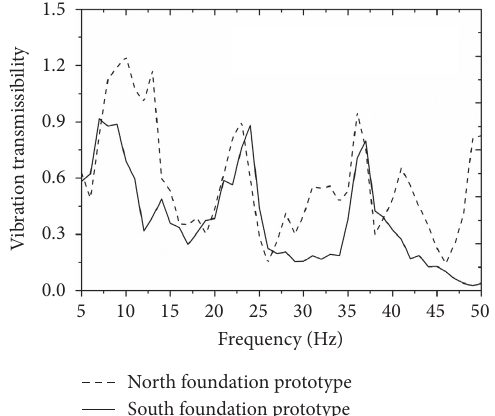
Figure 17: Transmissibility of vibrations transmitted to the foundation prototypes from subgrade soil.